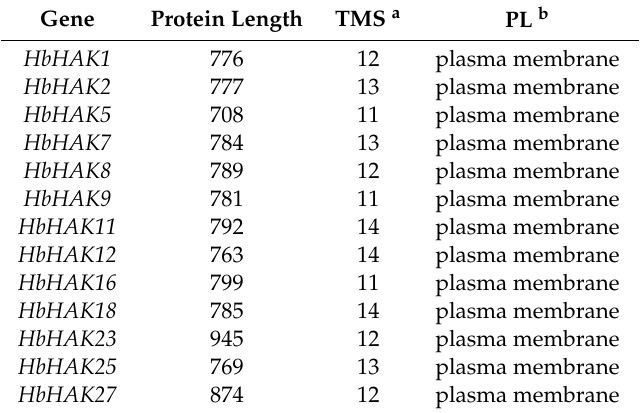
Table 1. The list of 13 identified HAK / KUP / KT proteins in H. brevisubulatum .